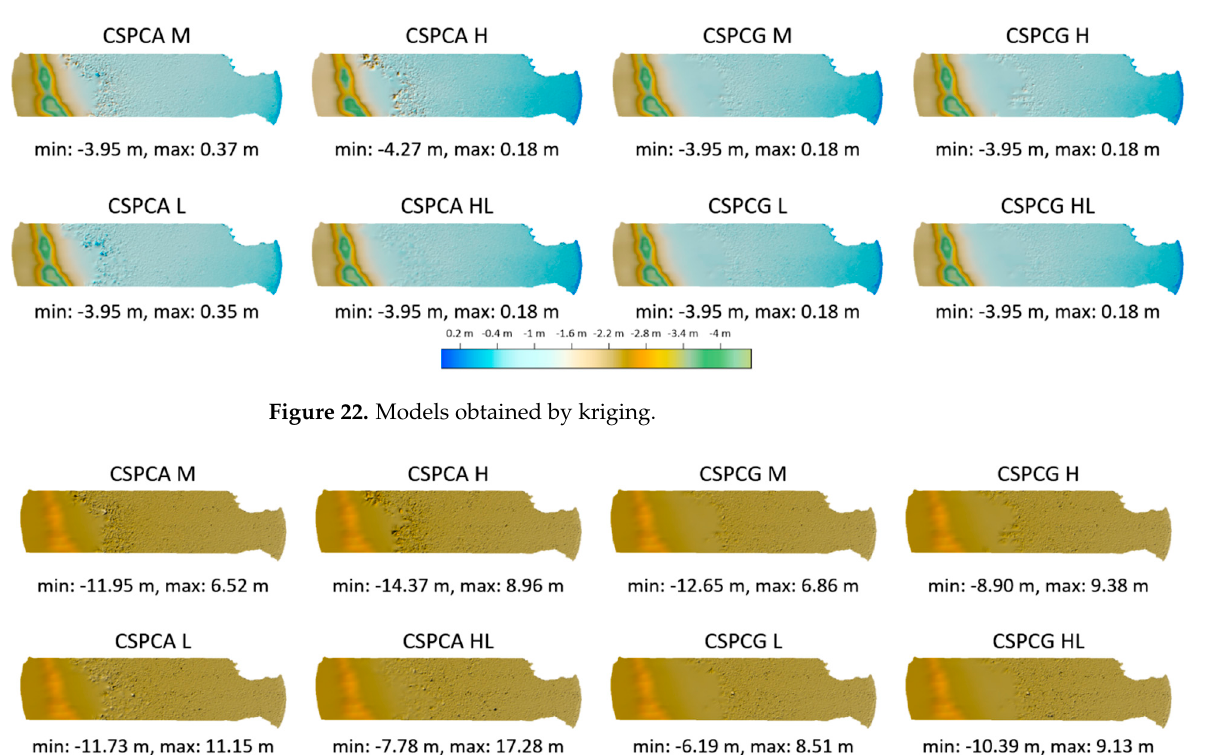
Figure 21. Models obtained by the inverse distance method.